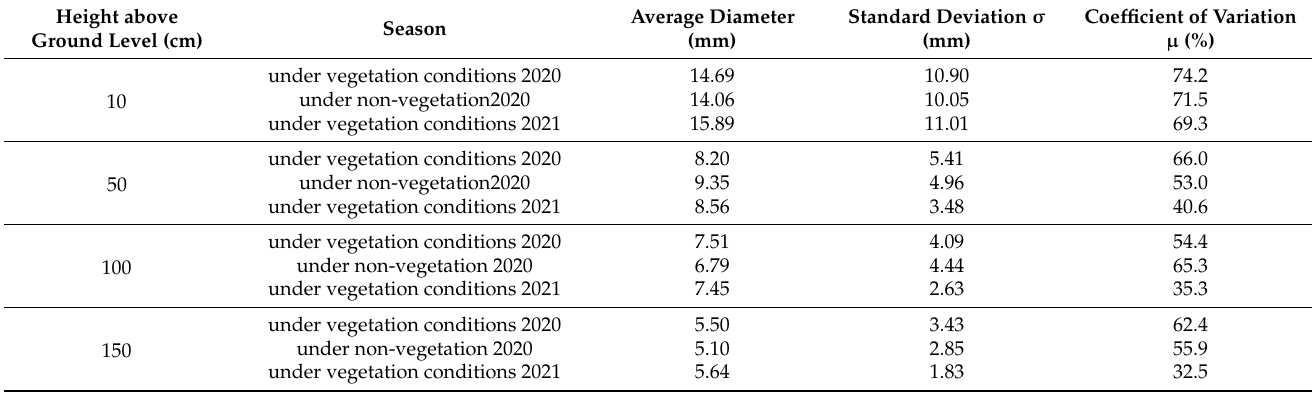
Table 1. Summary of the results of the series of measurements of the branches diameters of shrub No.